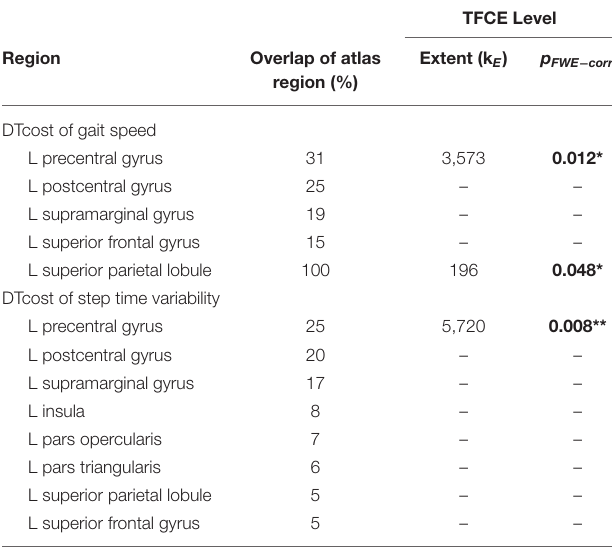
TABLE 3 | Regions of age difference in the relationship of sulcal depth with the DTcost of gait speed and step time variability. Region Overlap of atlas